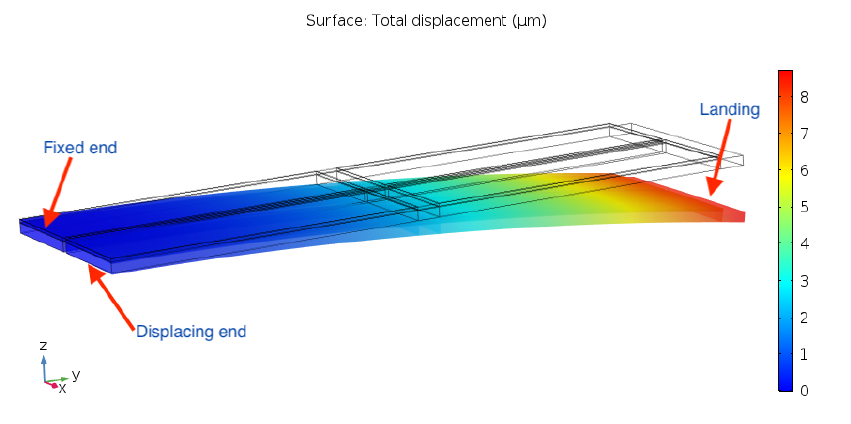
Figure 6. Second-order cantilever actuator flexural displacement.